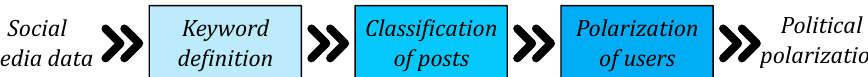
Figure 2. Execution flow of Iterative Opinion Mining using Neural Networks